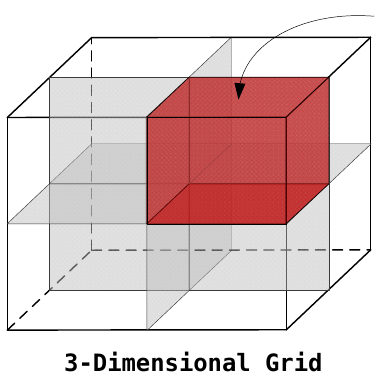
Figure 5. Example of AABB generation for 3-D cylinder.